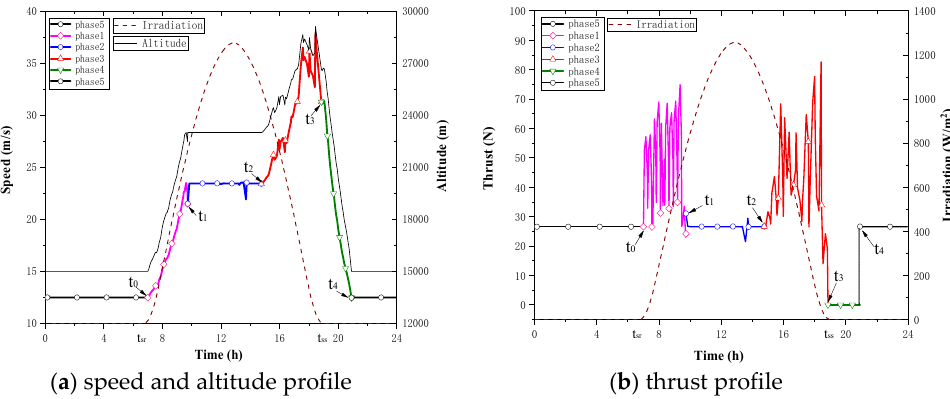
Figure 7. Optimal speed and altitude and thrust profile with minimal battery mass.